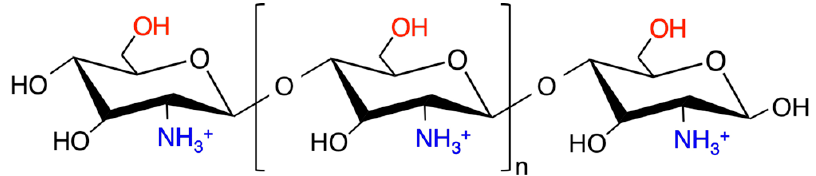
Figure 2. Schematic representation of chitosan. Functional groups C 2 -NH 2 and C 6 -OH and are represented in blue and red color, respectively.